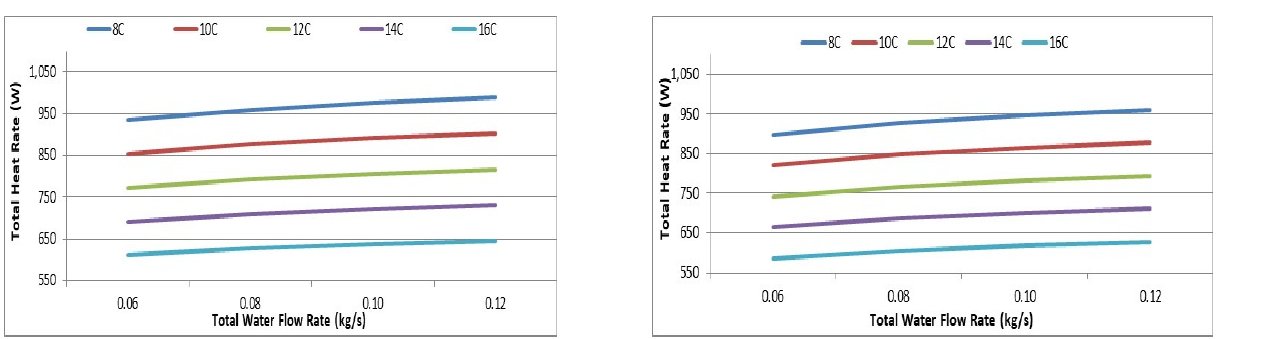
Fig. 6. The total heat rate of terminal units at 8, 10, 12, 14 and 16 °C water supply temperature and valve opening: Valve 1=100%, Valve 2=75 % and Valve 3=100.